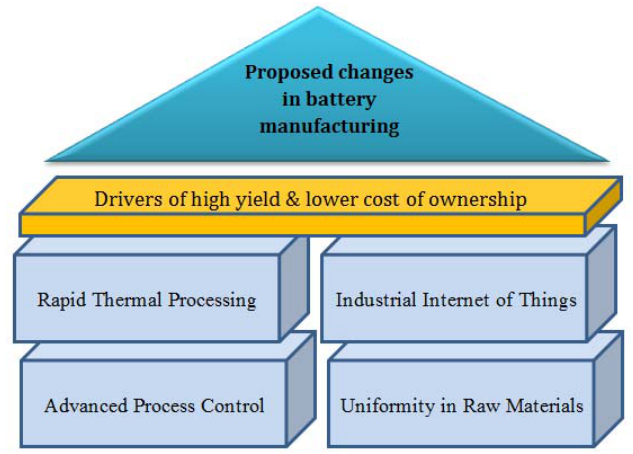
Figure 8. Proposed changes and their impact to bring down cost of ownership (COO).